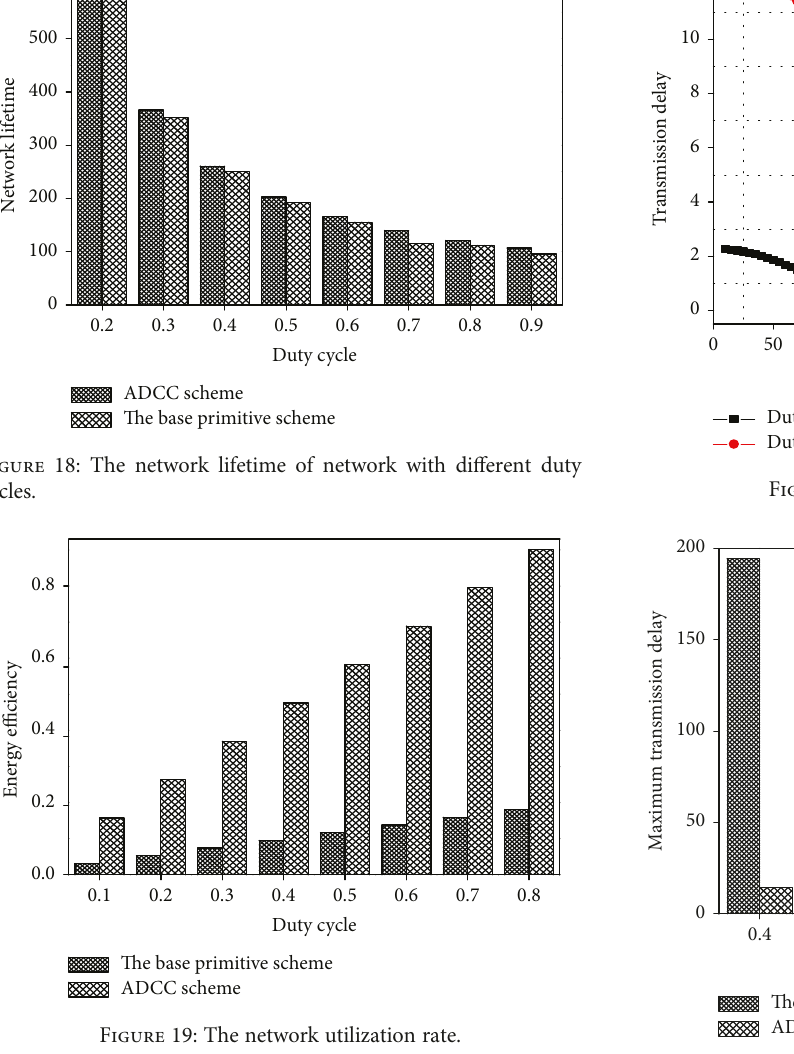
Figure 21: The maximum transmission